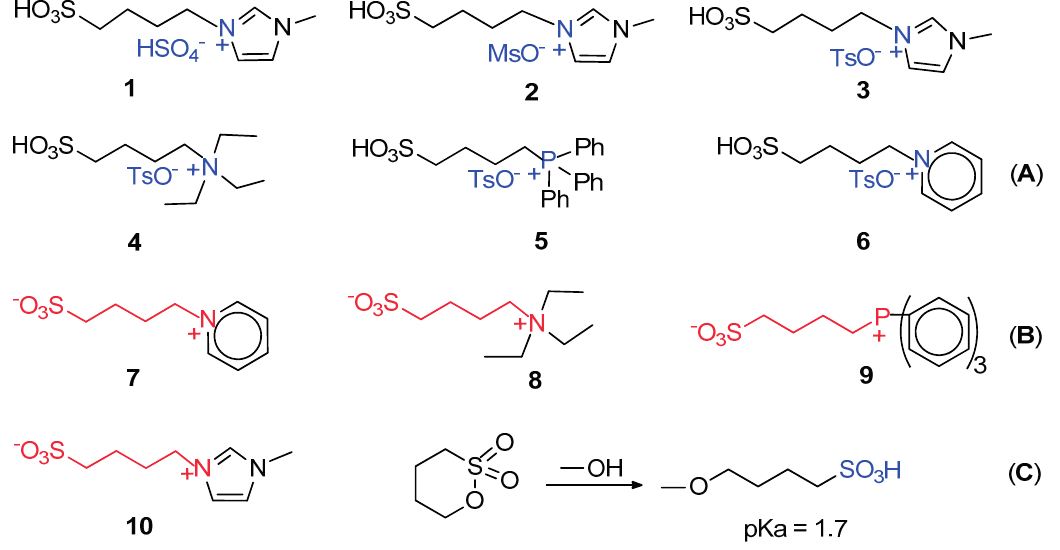
Figure 9. BAILs ( A ) and zwitterions ( B ) for the ethene hydromethoxycarbonylation; opening of 1,4-butansulfone with MeOH to the corresponding acid ( C